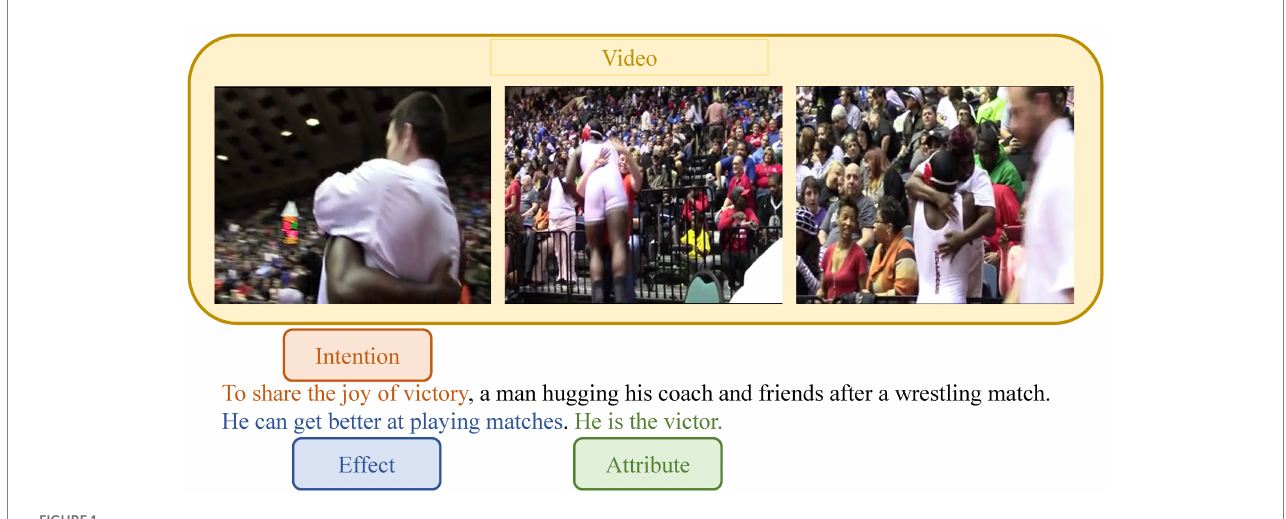
FIGURE 1 The example of the video-based commonsense caption